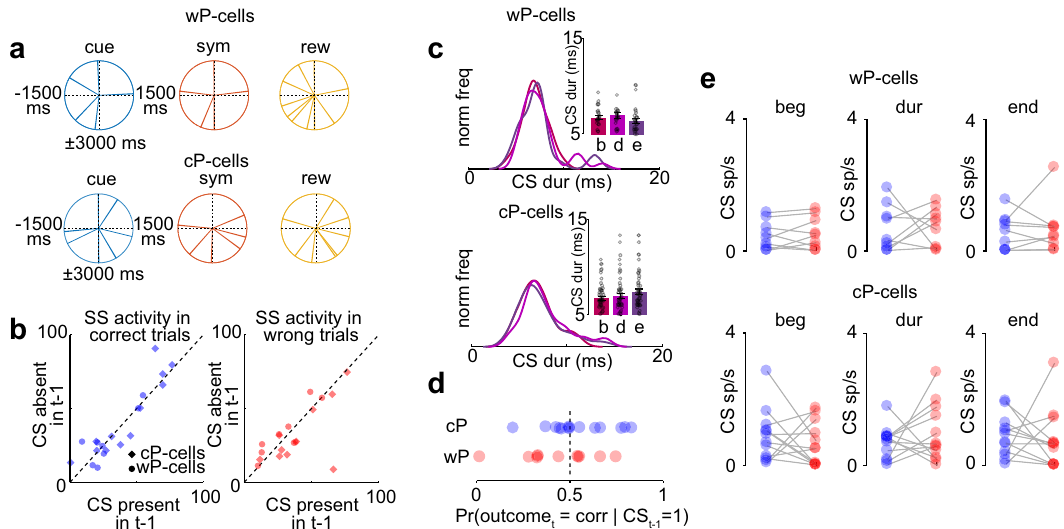
Fig. 5 SS and CS formed independent channels of neural encoding during reinforcement learning. a Polar plots (of the entire trial period) of time of signi fi cant CS modulation during learning relative to the time of cue onset (left), symbol onset (middle) and reward onset (right) for each cell for all wP- cells (top) and cP-cells (bottom). Each line on the plot represents time of signi fi cant modulation of CS (in ms) relative to the respective event signifying the temporal relationship between delta epoch and CS activity. b Left: SS activity for wP-cells in correct (left) and wrong (right) trials with CS present in the previous trial (abscissa) vs CS absent in the previous trial (ordinate). Right: same as left; but for cP-cells. c Duration of CS waveforms at the beginning (b), during (m), and end (e) of delta epoch for wP-cells (left) and cP-cells (right). Histograms were normalized to the maximum frequency among all epochs. d Probability that a trial (t) during learning would be correct, given there was a CS in the previous trial (t – 1) in cP-cells (left) and wP-cells (right). e Peak CS activity for correct (blue) and wrong (red) trials during learning at the beginning (left), during (middle), or the end (right) of delta epoch for cP-cells (top) and wP-cells (bottom). Data shown as mean ± s.e.m. Source data are provided as a Source Data fi